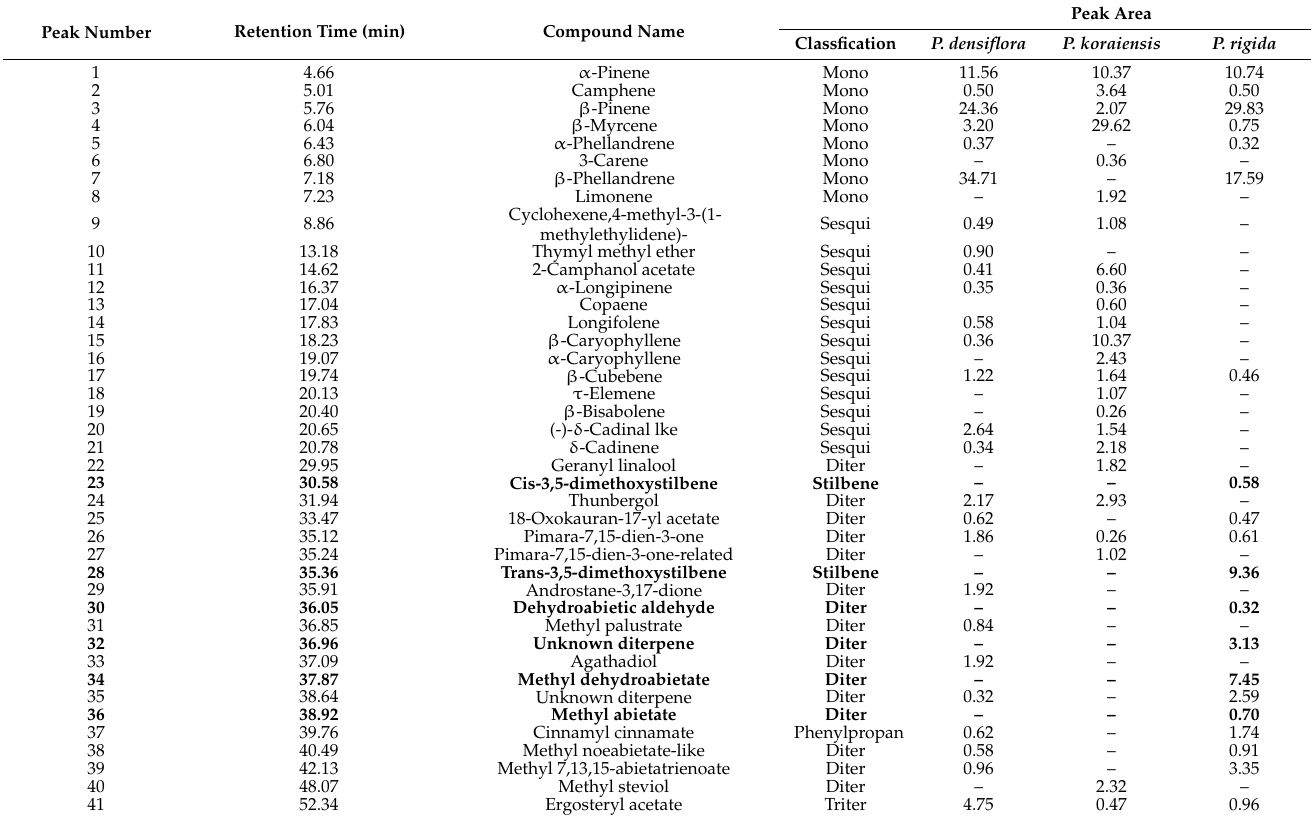
Table 1. Identification of compounds was achieved using computer matching of the mass spectra with the NIST library or with mass spectra obtained from standard compounds.Compounds presented as dashed lines with amounts less than 0.05% are indicated. The dashed line indicates not detected and/or trace amounts. The bold characters/numbers indicate P. rigida Mill. resin-specific compounds. The values of peak area are mean of three replicates.